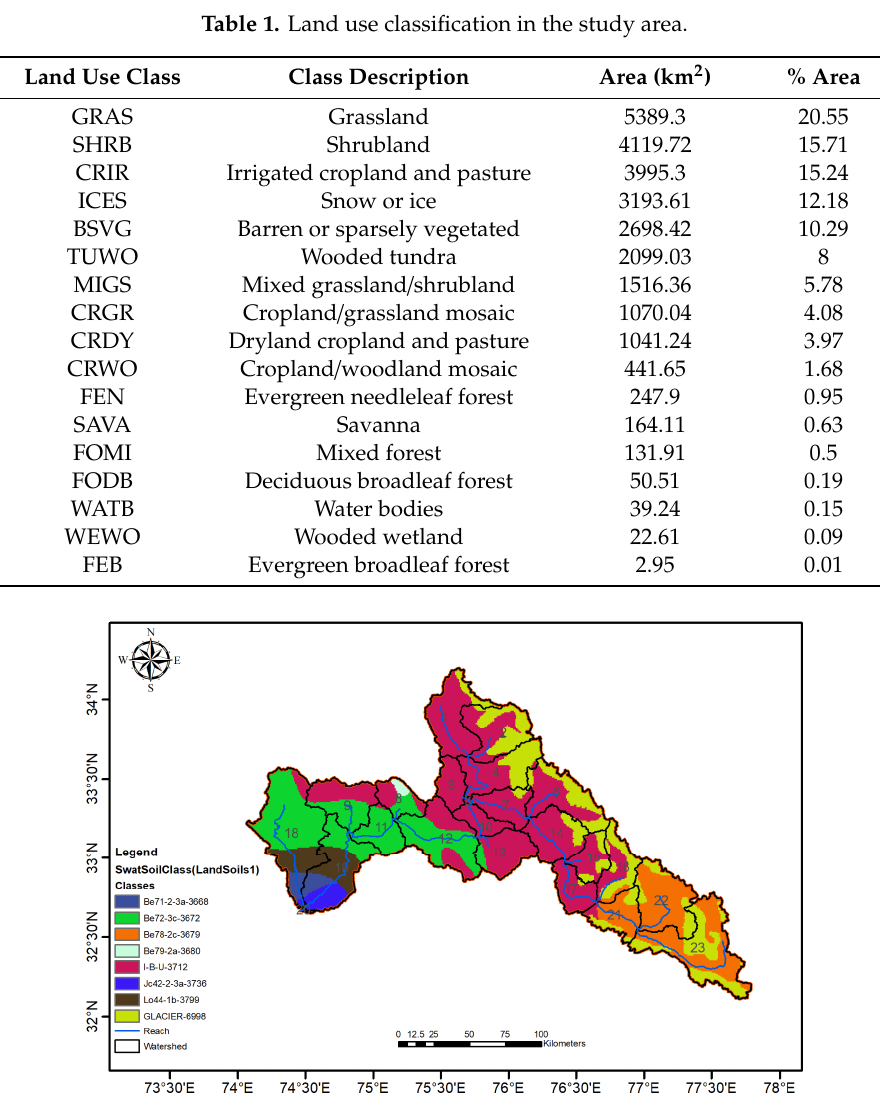
Figure 5. Soil type map of the study area. Table 2. Soil classification in the study area.